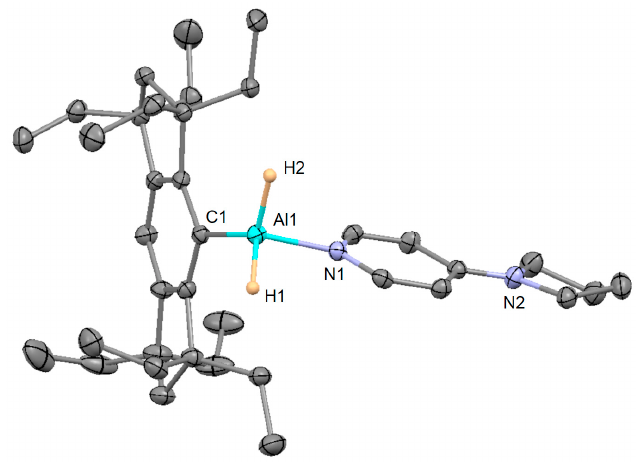
Figure 2. Molecular structure of 4 (molecule A). The thermal ellipsoids are shown at the 50% probability level. The hydrogen atoms, except for the Al–H groups, are omitted for clarity.